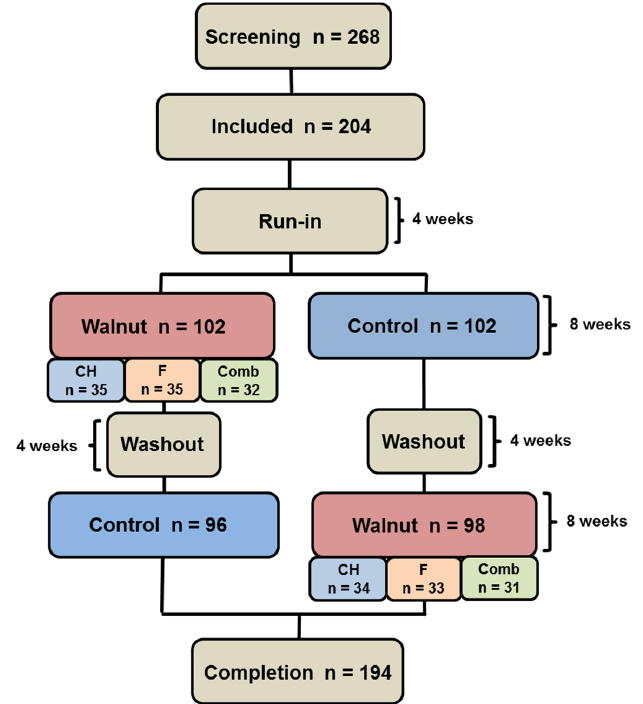
Figure 1. Flowchart of study subjects. In total, 204 subjects were randomized. Ten subjects dropped out due to disease ( n = 2), medication ( n = 1), personal reason ( n = 5), protocol violation ( n = 2). A total of 194 subjects were included in statistical evaluation. CH: carbohydrate restriction, F: fat restriction, Comb: combined carbohydrate and fat restriction.